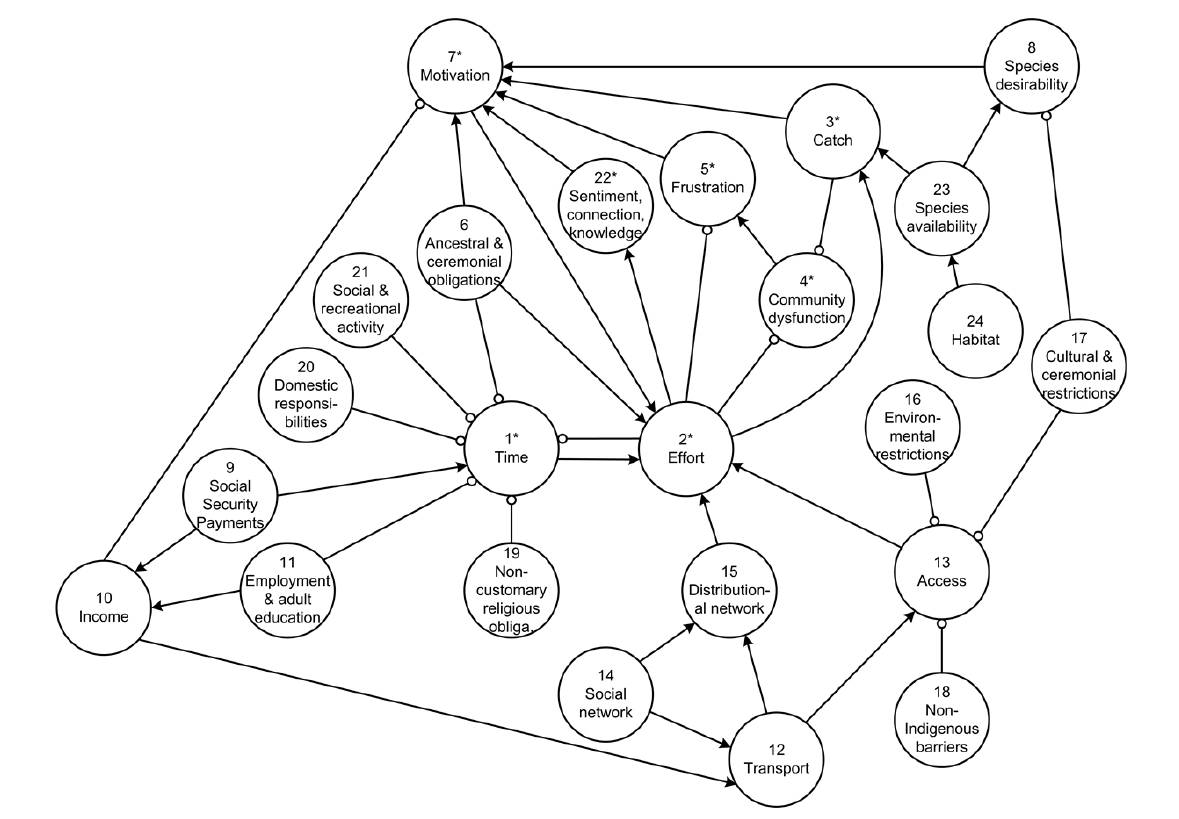
Fig. 2. Generalized model of factors regulating aquatic subsistence by active adult indigenous hunters in North Australian river catchments. See Tables 3 and 4 for descriptions of model nodes and links. Asterisks denote model nodes that contribute to system feedback